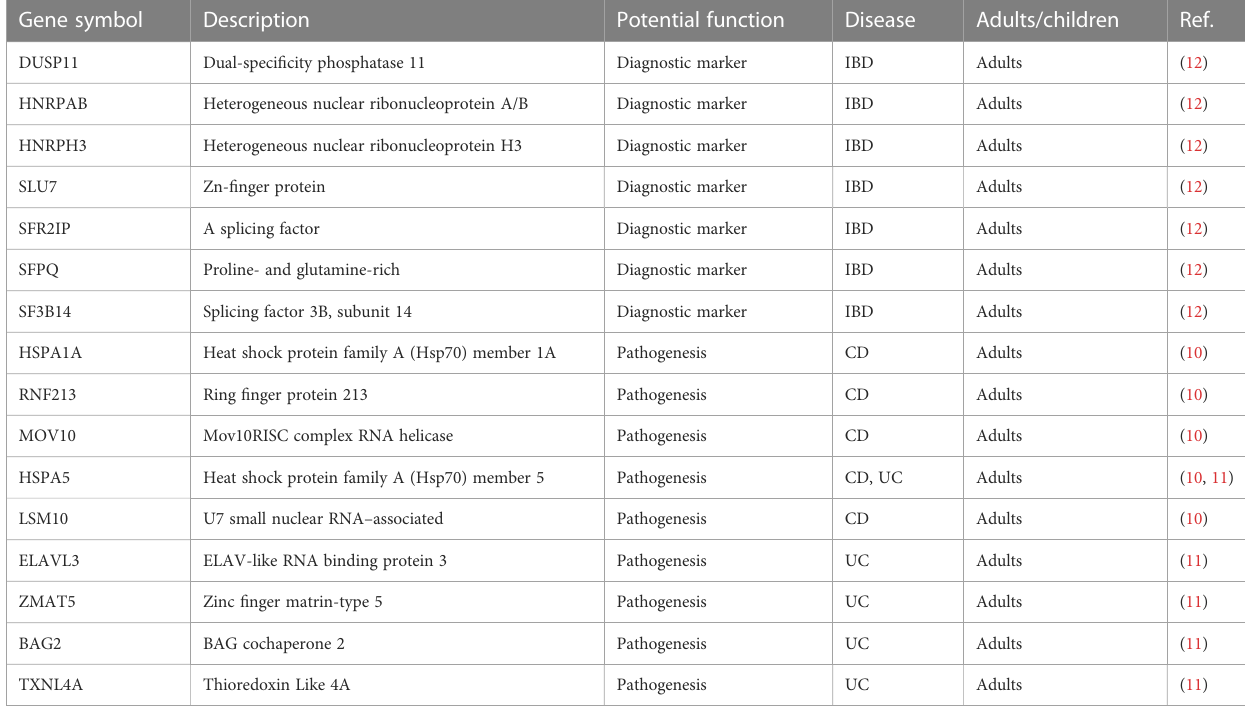
TABLE 2 Studies reporting alterations of RNA splicing factor expression in